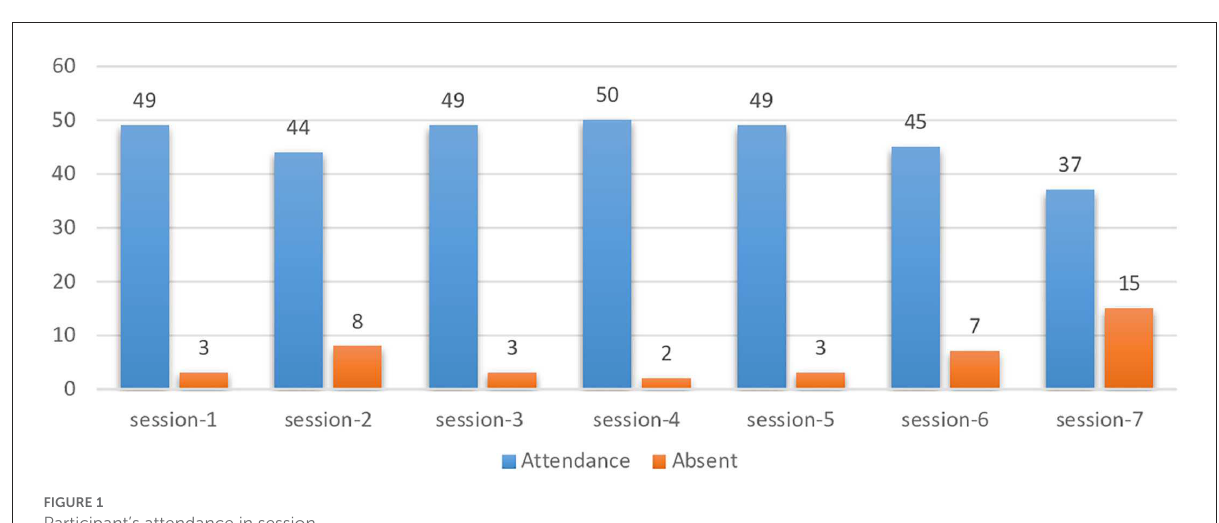
FIGURE1 Participant’s attendance in